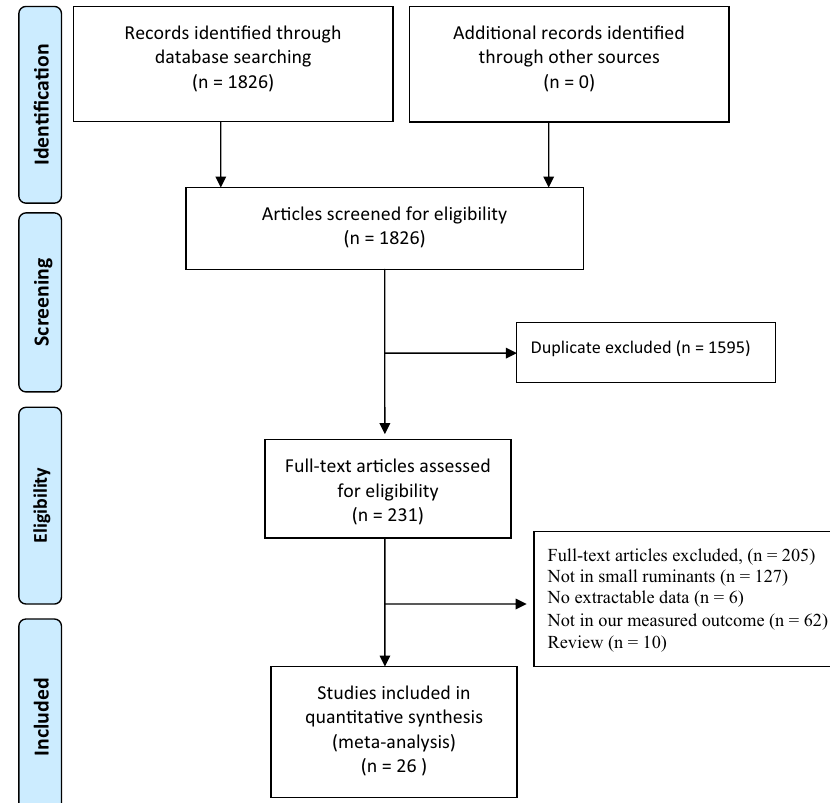
Figure 1: Study selection fl ow chart for the meta -